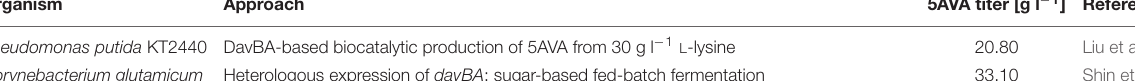
TABLE 1 | Comparison of the 5AVA production by different engineered microbial strains and production of amino acids by B. methanolicus . Organism Approach